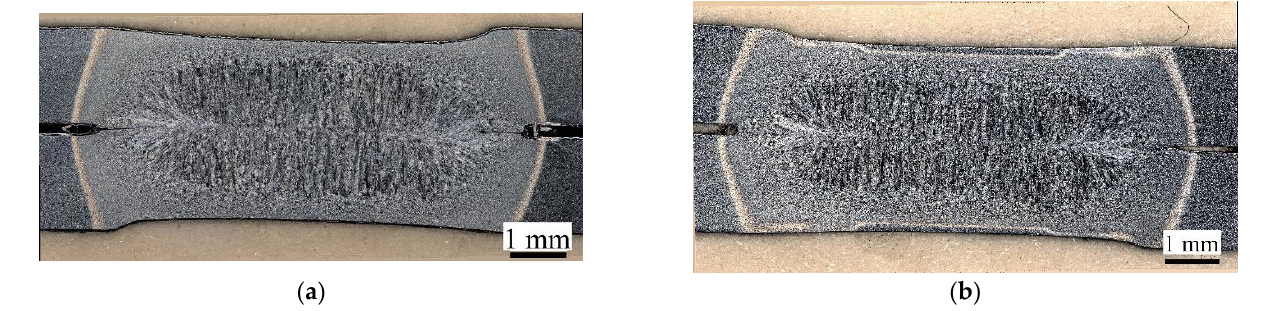
Figure 4. Representative cross-sections of ( a ) Al-Si coated hot-stamped Usibor 1500 and ( b ) uncoated hot-stamped Usi- bor1500.2.4. Experimental Setup.